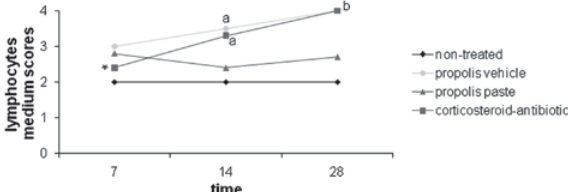
Figure 2- Progression of lymphocytes medium